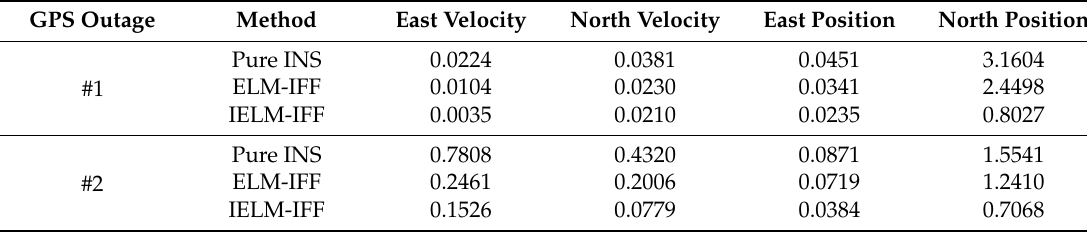
Table 5. The RMSEs of the velocity (m/s) and position (m) from the pure INS, ELM-IFF, and IELM-IFF.